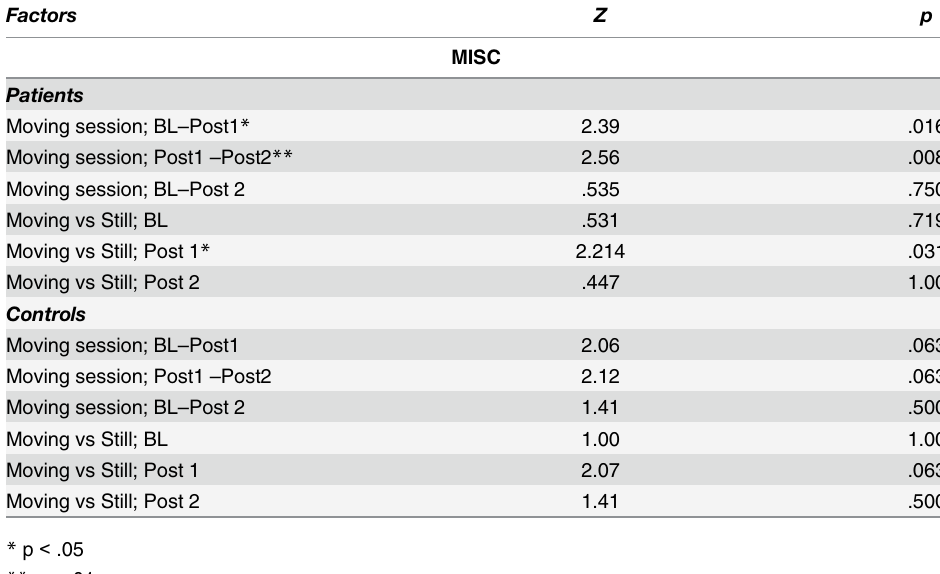
Table 4. Wilcoxon signed rank tests as a follow-up for significant Friedman tests for the